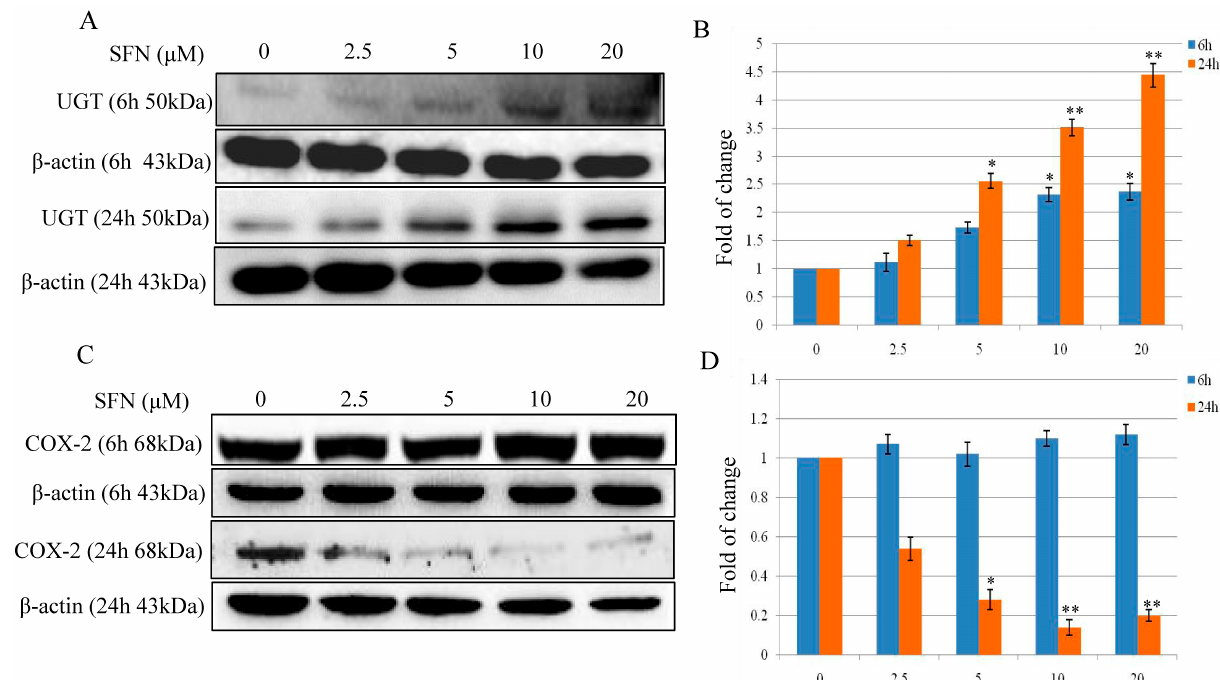
Figure 4. Effect of SFN on UGT and COX-2 expression in T24 cells. ( A , B ) Effect of SFN on UGT protein expression after treatment for 6 and 24 h. T24 cells were treated with SFN (2.5, 5, 10 and 20 µ M) for 6 and 24 h. ( C , D ) Effect of SFN on COX-2 protein expression after treatment for 6 and 24 h. T24 cells were treated with SFN (2.5, 5, 10 and 20 µ M) for 6 and 24 h. Data were normalized for β -Actin, and reported as fold variation with respect to the Vehicle group. Statistical significance versus control: * p < 0.05, ** p < 0.01.